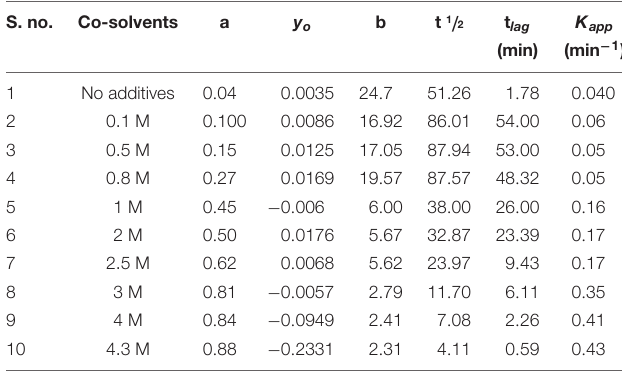
TABLE 2 | Change in kinetic parameters associated with aggregation of BSA in presence of monosodium glutamate at varying concentration from (0.1 to 4.5 M) at temperature 60 ◦ C.